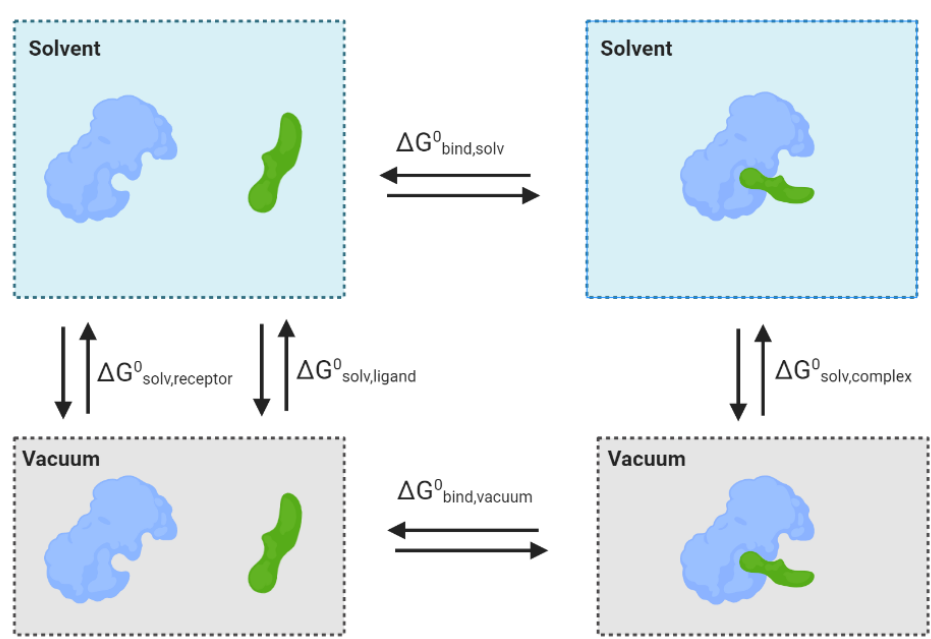
Figure 16. Thermodynamic cycle of binding free energy calculations for protein–ligand complex. ΔG 0 bind,solv is the free energy of interest, solvation energy and binding energy in vacuum are directly calculated terms.